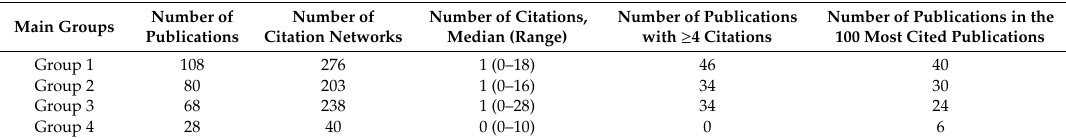
Figure 3. Clustering function in the citations network of sports vision. Table 7. Information about citations network of the four main groups.